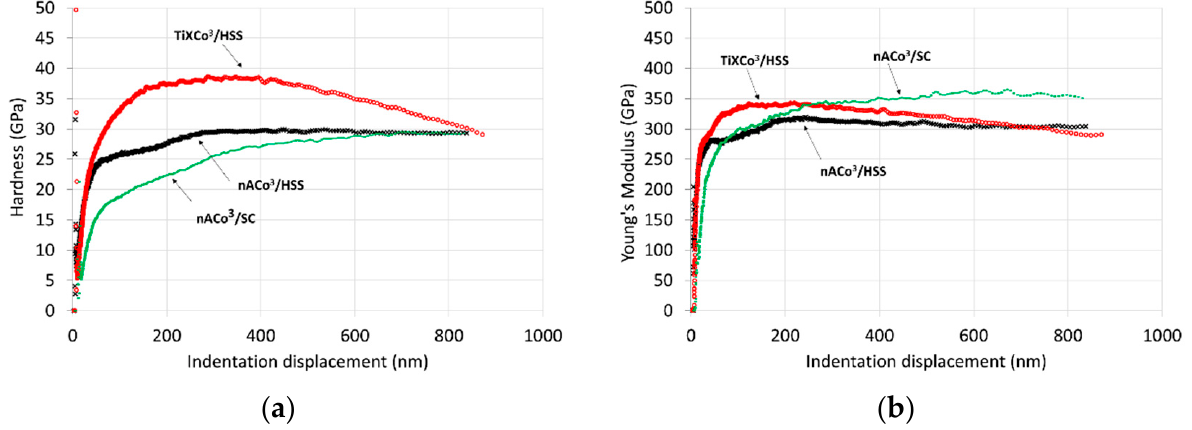
Figure 6. Calculated mechanical properties of experimental samples: ( a ) hardness H ; ( b ) elastic modulus E .